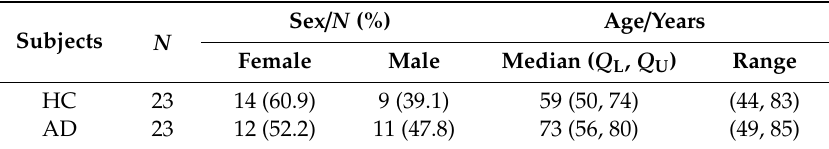
Table 1. The demographic characteristics of